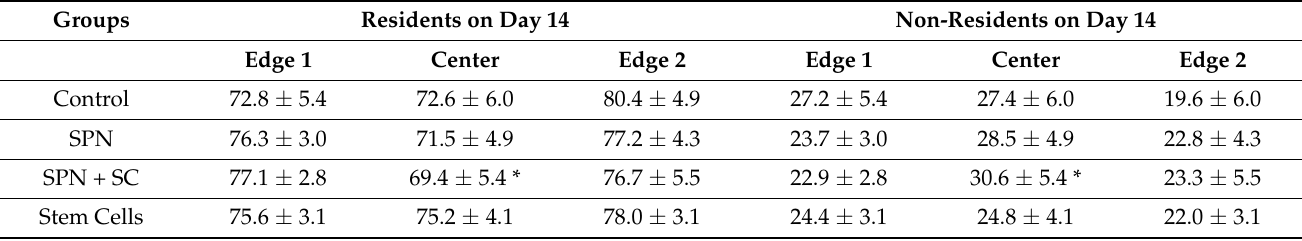
Table 3. The content of resident and non-resident cells in the center and edges of wounds of different groups on day 14 (%). Groups